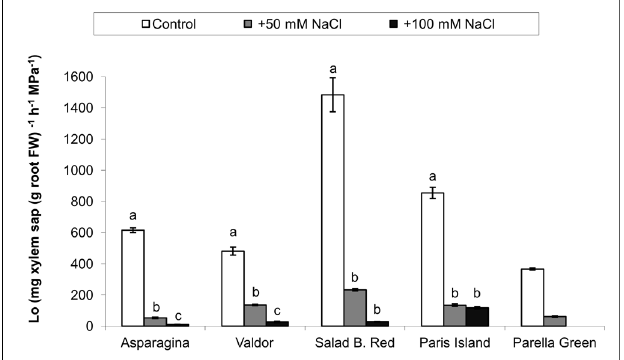
Fig. 3: Root hydraulic conductance (L 0 ) of five lettuce cultivars exposed to salt stress. FW – fresh weight. Each value is the mean of five samples ± SE. Different letters indicate significant differences among treat - ments of the same cultivar, at P < 0.05, according to the Tukey test.